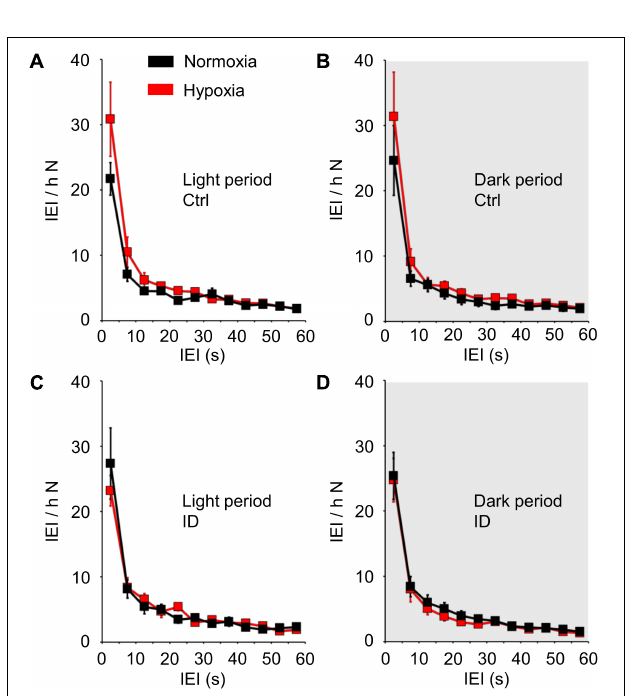
FIGURE 5 | Number of different categories of tibialis anterior (TA) electromyographic (EMG) events per hour of time spent in non-rapid-eye-movement sleep (N) during the light period (L) and the dark period (D, gray shading) in mice fed control diet (Ctrl) or iron-deficient diet (ID). (A) Total number of TA EMG events per hour N time; (B,C) number of TA EMG events separated by inter-event intervals (IEI) between 0.5 and 10 s (short-IEI TA EMG events) or between 10 and 60 s (long-IEI TA EMG events), respectively, per hour N time; (D) number of long-IEI TA EMG events in series of four or more, expressed per hour N time. Data are means ± SEM with n = 8 per group. † P < 0.05, L vs. D ( t